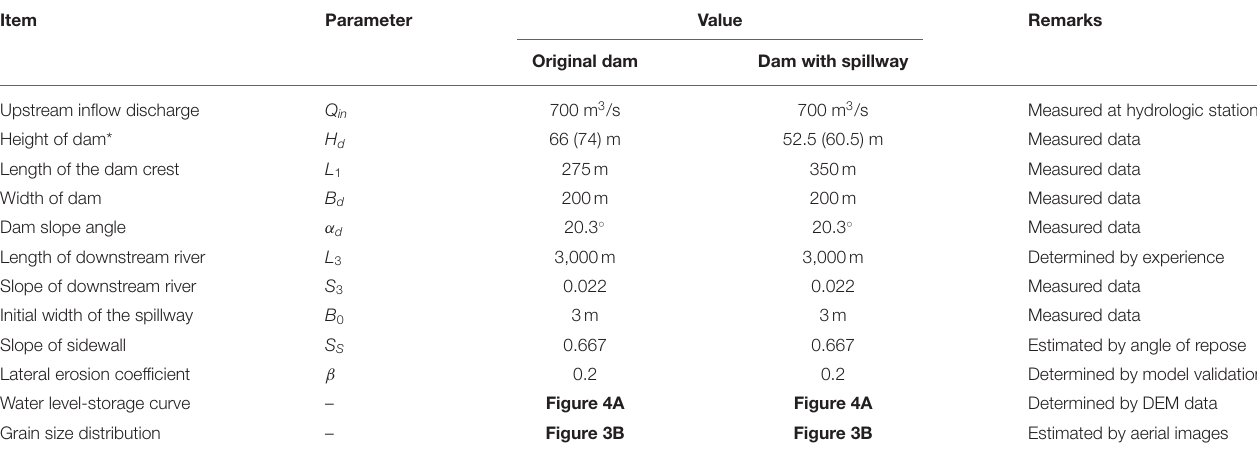
TABLE 2 | Parameters adopted in the breach simulation of the barrier lake in Baige village. Item